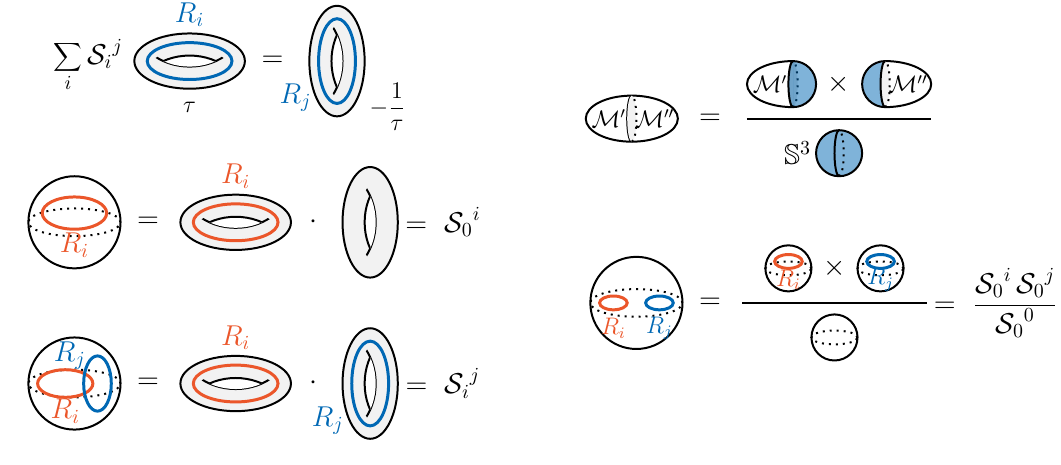
Figure 3 . Sketches of the computations of partition functions in Chern-Simons theory on S 3